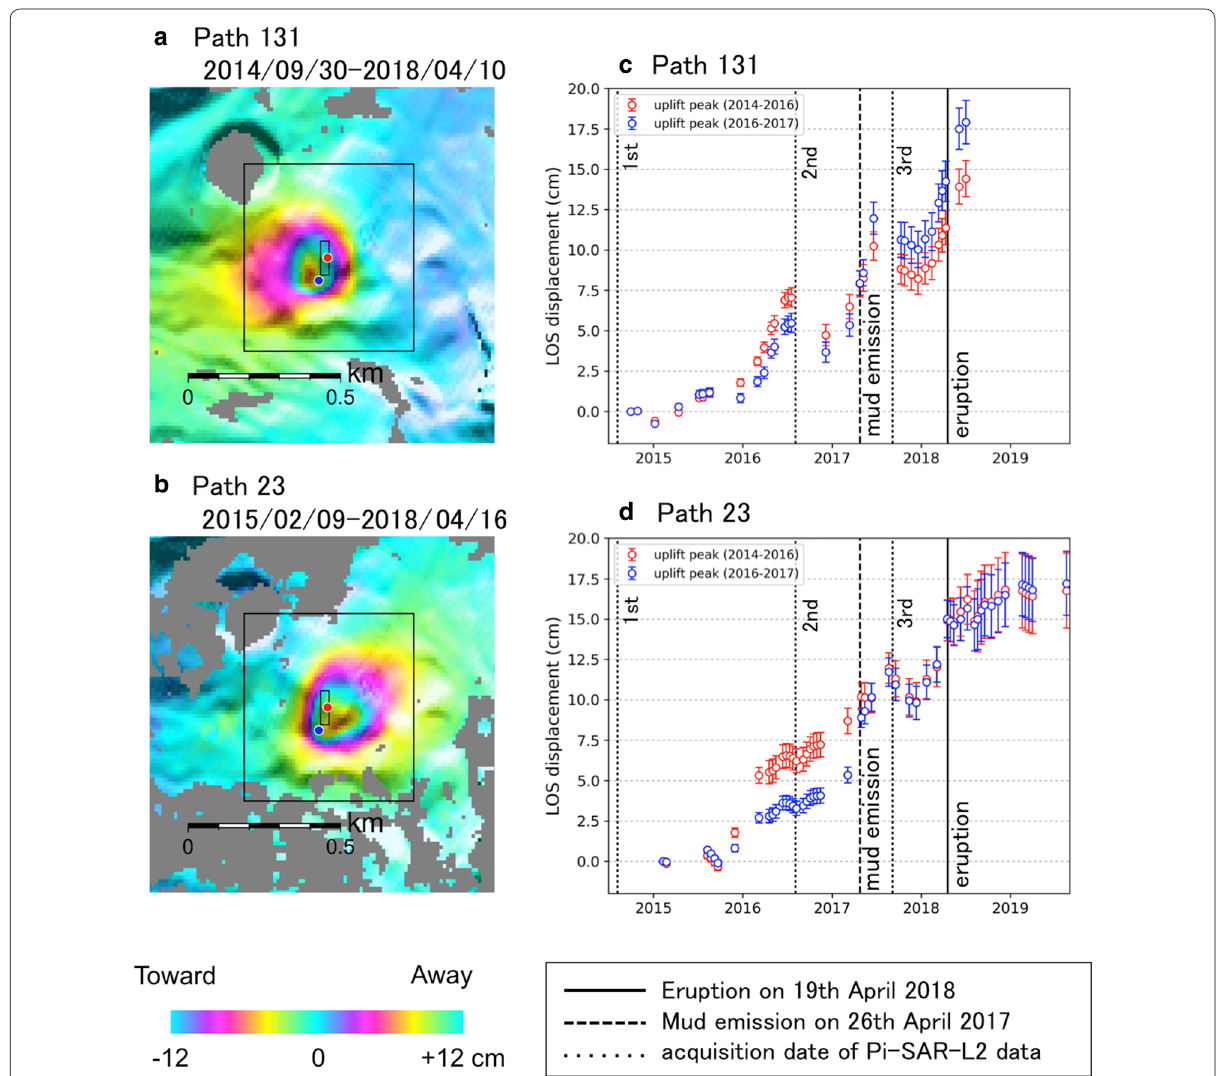
Fig. 8 Cumulative dLOS observed from a path 131 and b path 23. Symbols shown in a and b , such as the circles and rectangles, indicate the same information as in Fig. 6. Larger inset rectangles in a and b indicate displayed area of Fig. 6c, d correspond to the dLOSs time series of a and b at peak A (the red circle) and peak B (the blue circle). The vertical bars with the red and blue circles indicate the standard deviation of the estimated dLOS. Positive values in c and d correspond to ground motion toward the satellite. Solid, dashed and dotted lines indicate the timing of the phreatic eruption on April 19, 2018, the timing of the mud eruption from the fumarole vent A on April 26, 2017, and the acquisition date of the Pi-SAR-L2 data (1st, 2nd and 3rd). Around the day of the mud eruption, the dLOSs speed at the inflation peak during 2016–2018 exceeded ( c ) or reached ( d